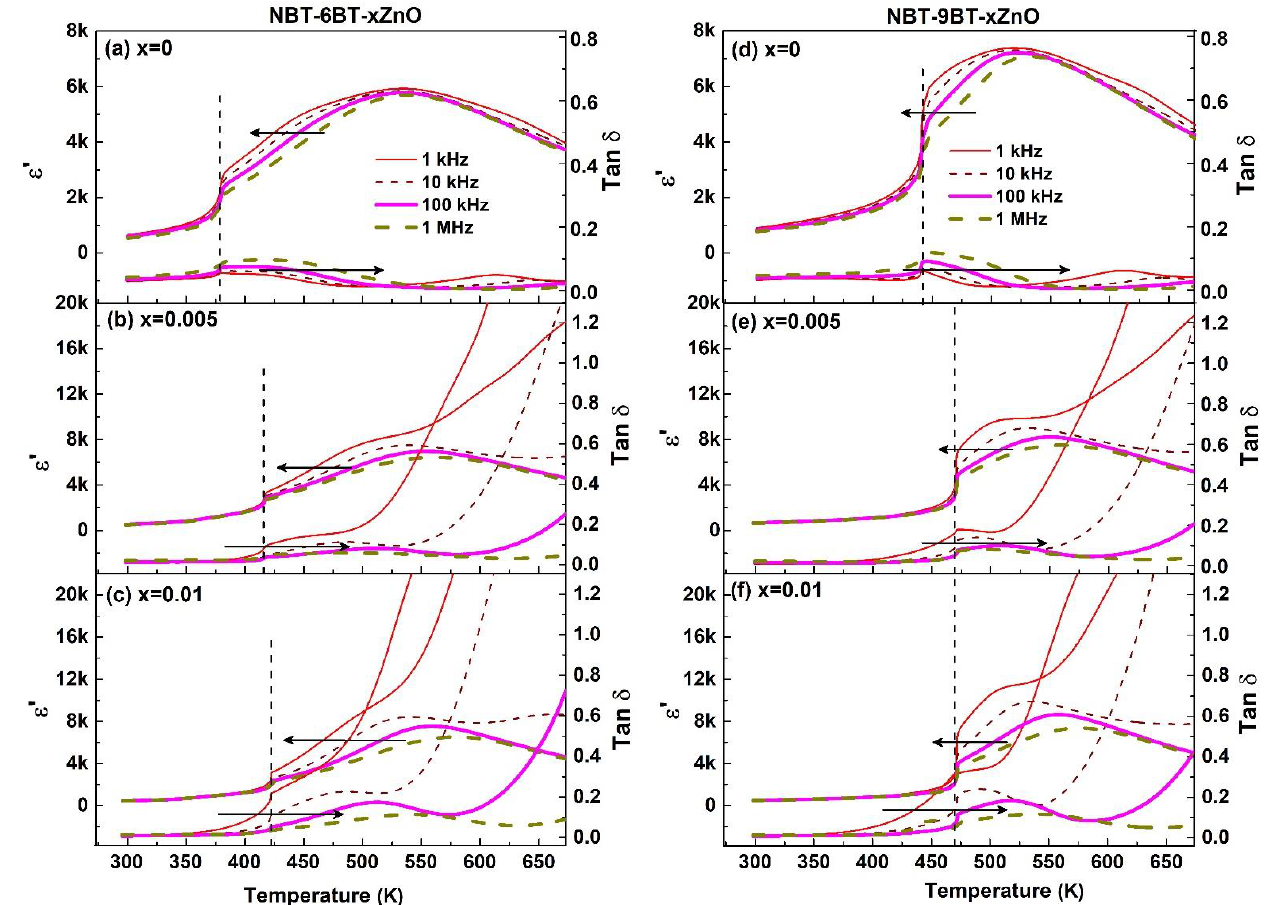
Figure 5. Dielectric permittivity ( ε r ) and loss ( tan δ ) of poled samples as a function of temperature at various frequencies for ( a ) NBT-6BT, ( b ) NBT-6BT-0.005Zn, ( c ) NBT-6BT-0.01Zn, ( d ) NBT-9BT, ( e ) NBT-9BT-0.005Zn, and ( f ) NBT-9BT-0.01Zn.